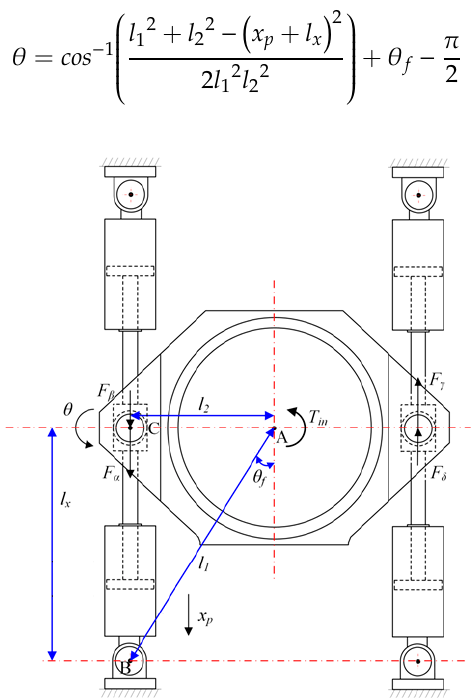
Figure 12. Free-body diagram of the torque-applying device [11]. Table 2. Specifications of the torque-applying device.